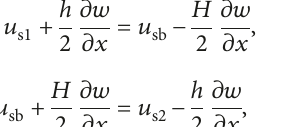
Figure 1: Structural diagram of axially moving SMA laminated